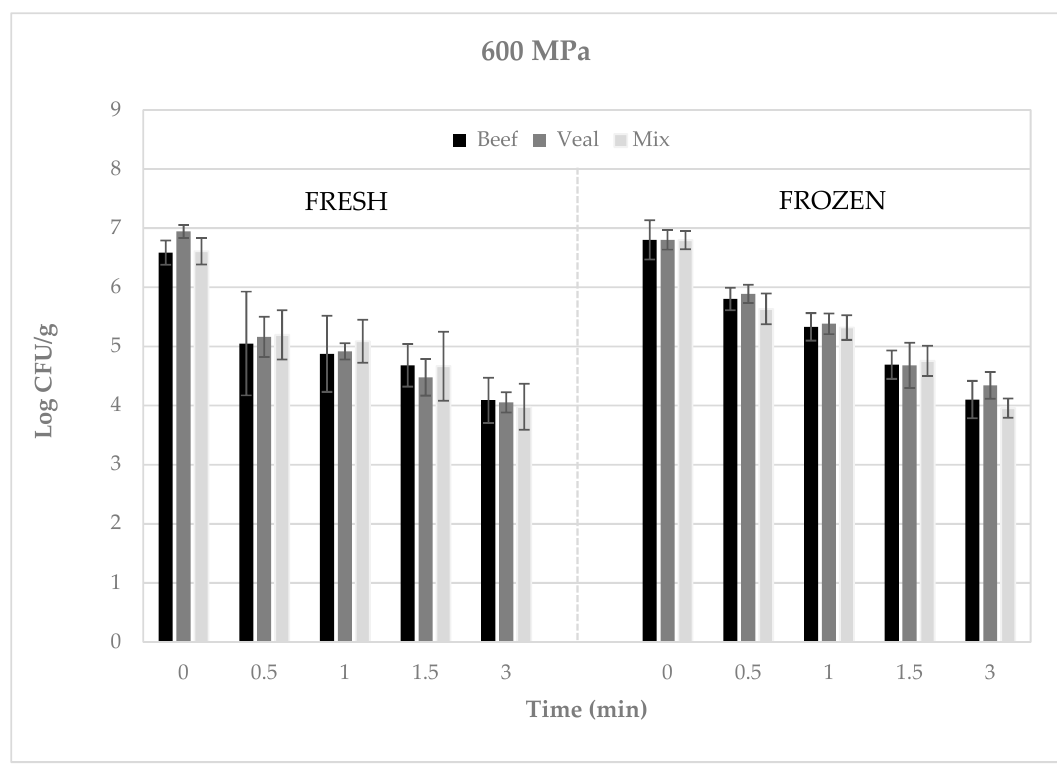
Figure 2. Recovery of Shiga toxin-producing Escherichia coli (log CFU/g) from refrigerated or frozen raw meatballs following pressure treatment at 600 MPa. Error bars represent the standard deviation of the mean (N = 3, n = 3).